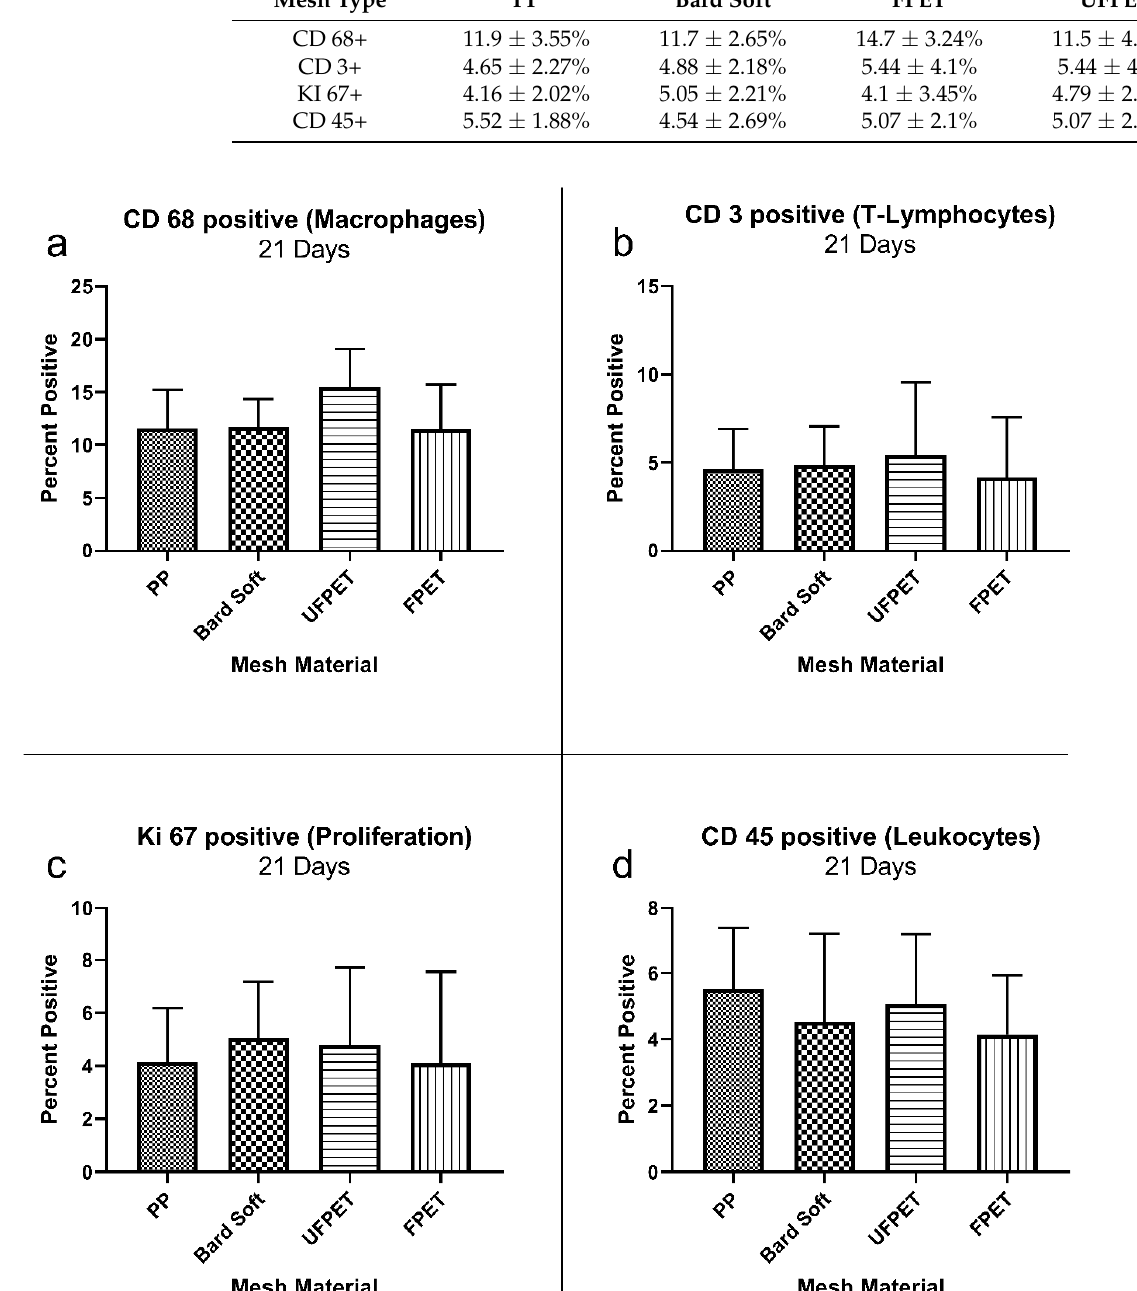
Figure 6. Immuno-histologic characterization of foreign body response after 21 days showing marker-positive cells in the region of interest surrounding the subcutaneously implanted meshes. Kruskal–Wallis comparisons did not reach the significance threshold of p < 0.05. ( a ) CD 68 positive (macrophages), ( b ) CD 3 positive (T-lymphocytes), ( c ) KI 67 positive (proliferation), ( d ) CD 45 positive (leukocytes).